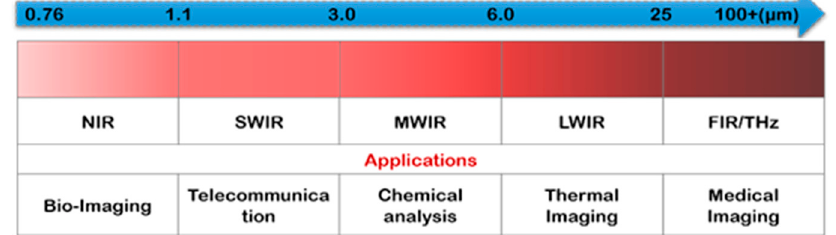
Figure 1. The typical photodetector applications at broad infrared detection spectral bands, including NIR, SWIR, MWIR, LWIR and FIR/THz.